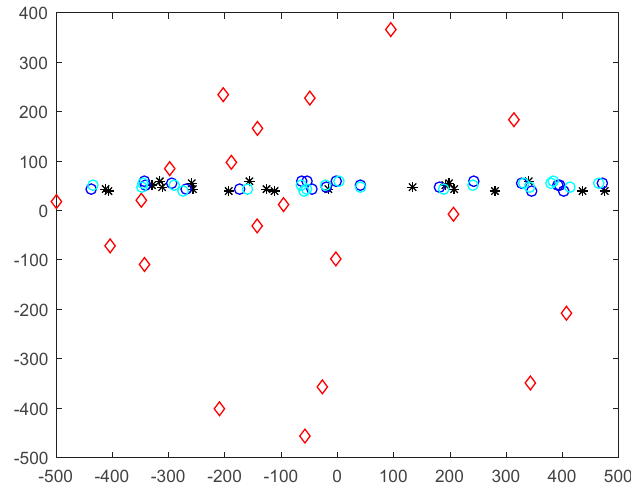
Figure 2. Vehicular and cellular users.